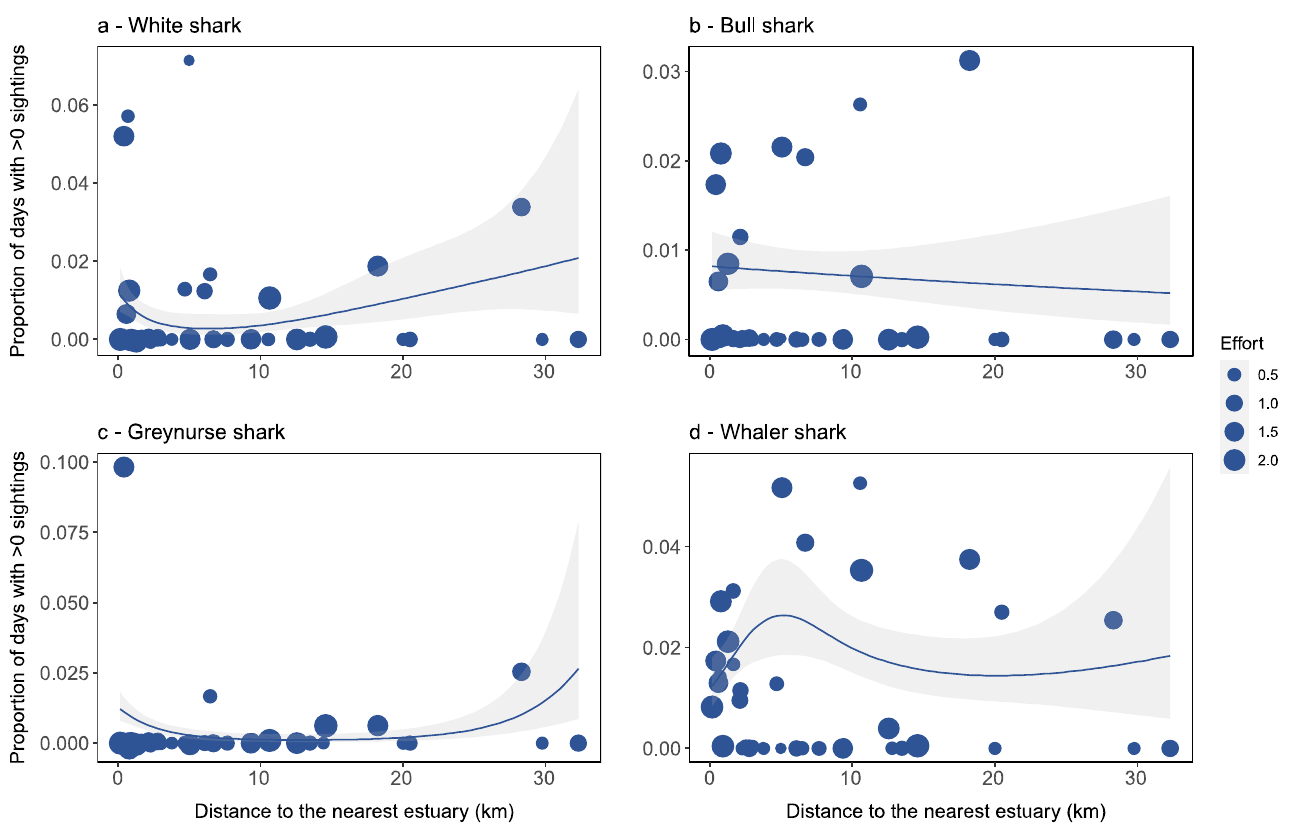
Figure 2. Detection rates for each beach location in relation to distance to the nearest estuary for ( a ) white shark, ( b ) bull shark, ( c ) greynurse shark, and ( d ) whaler shark species, and estimated response curves with a 95% confidence region. Points are sized proportionally to the total flight effort at each location proportional to the average effort. Thus, a weight of 1.0 equals average flight effort, <1 equals below average effort, and >1 equals above average effort. Greynurse sharks were significantly associated with distance to the nearest headland ( p < 0.001; Table 1), with all locations that recorded greynurse sharks being within prox- imity to headlands (Figure 3c). In comparison, this factor did not explain significant vari- ation for white, bull and whaler shark sightings (Figure 3a,b,d). Distance to the nearest island was the best predictor for whaler shark occurrence (Table 1), and bull ( p < 0.05), greynurse ( p < 0.01) and whaler ( p < 0.001) sharks were significantly associated with this factor. However, for white sharks, distance to the nearest island did not explain significant variation in observations (Figure 4a). Overall, we found that bull, greynurse and whaler shark sightings all decreased significantly with an increase in distance to the nearest is- land (Figure 4b – d).